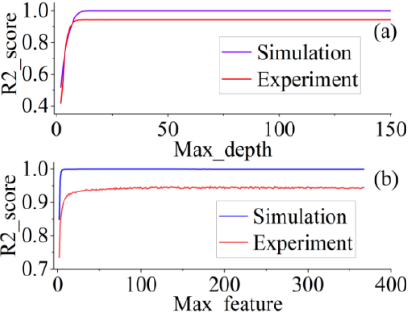
Figure 9. Performance curves under various parameters of RF. ( a ) R 2_ score with different Max_depth . ( b ) R 2_ score with different Max_feature .